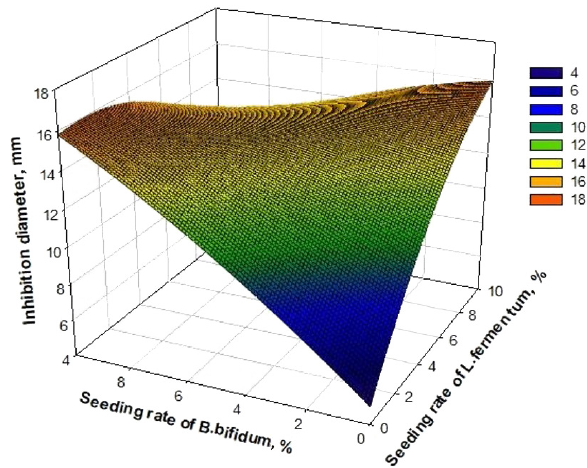
Figure 6 Response surface model of inhibition zone of Lactobacillus fermentum and Bifidobacterium bifidum against Bacillus cereus with seeding rates of Lactobacillus fermentum ( X ) and Bifidobacterium bifidum ( X ), 1 2 incubation temperature ( X ), and incubation time ( X ) 3 4 at temperature 0 (39.5°C) and time 0 (24